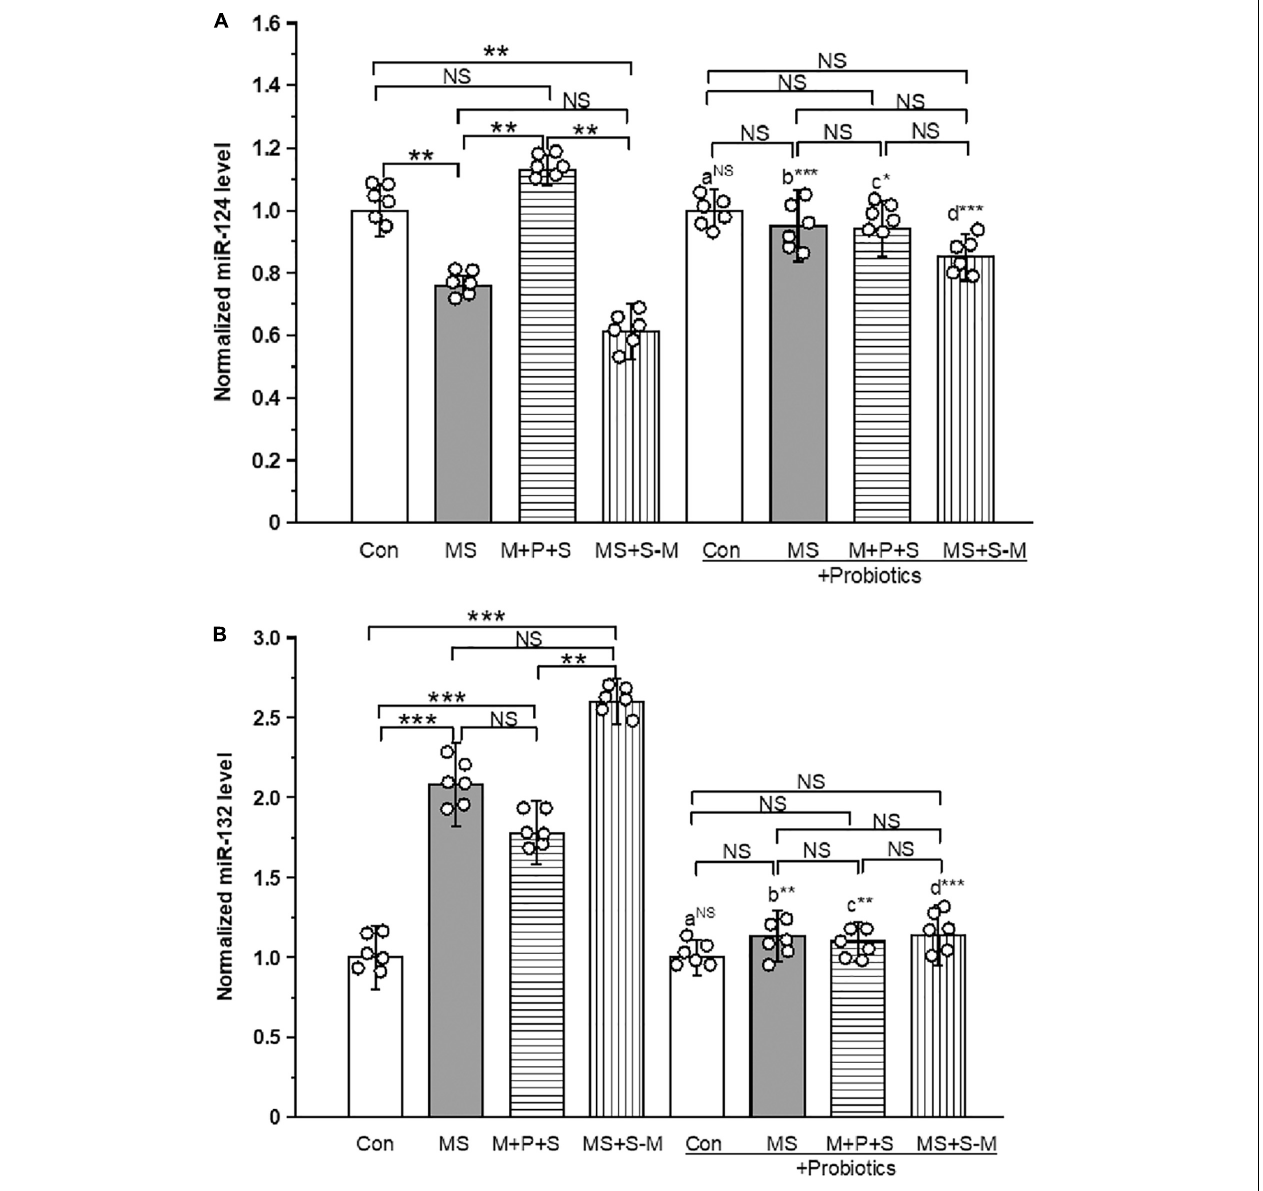
FIGURE 7 | Early life SSE differently regulated the expression of miR-124 (A) and miR-132 (B) . Supplementation of Lactobacillus normalized the expression of miR-124 and miR-132 levels. Values are presented as mean ± SEM. Significant differences between groups are indicated by *** P < 0.001, ** P < 0.01, * P < 0.05; a: con vs. con + Pro; b: MS vs. MS + Pro; c: M + P + S vs. M + P + S + Pro; d: MS+S–M vs. MS+S–M + Pro; NS, not